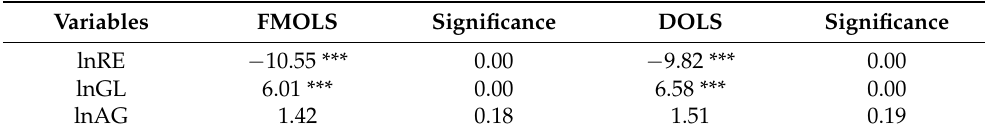
Table 7. FMOLS and DOLS tests (CO 2 ).